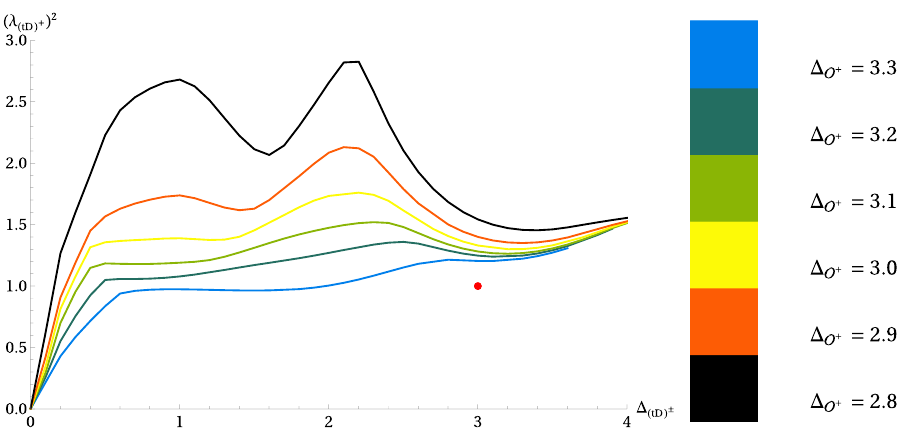
Figure 6. Bounds on ( λ ) 2 as a function of the scaling dimension of ∆ t D ( t D ) + scaling dimension of the first parity-even singlet ∆ . The gap on the dimension ∆ O + ∆ , and all other gaps are set to 0.001. The GFB solution given in eq. (2.25) is marked by the ( t D ) + red dot. Λ = 33 , P = 63